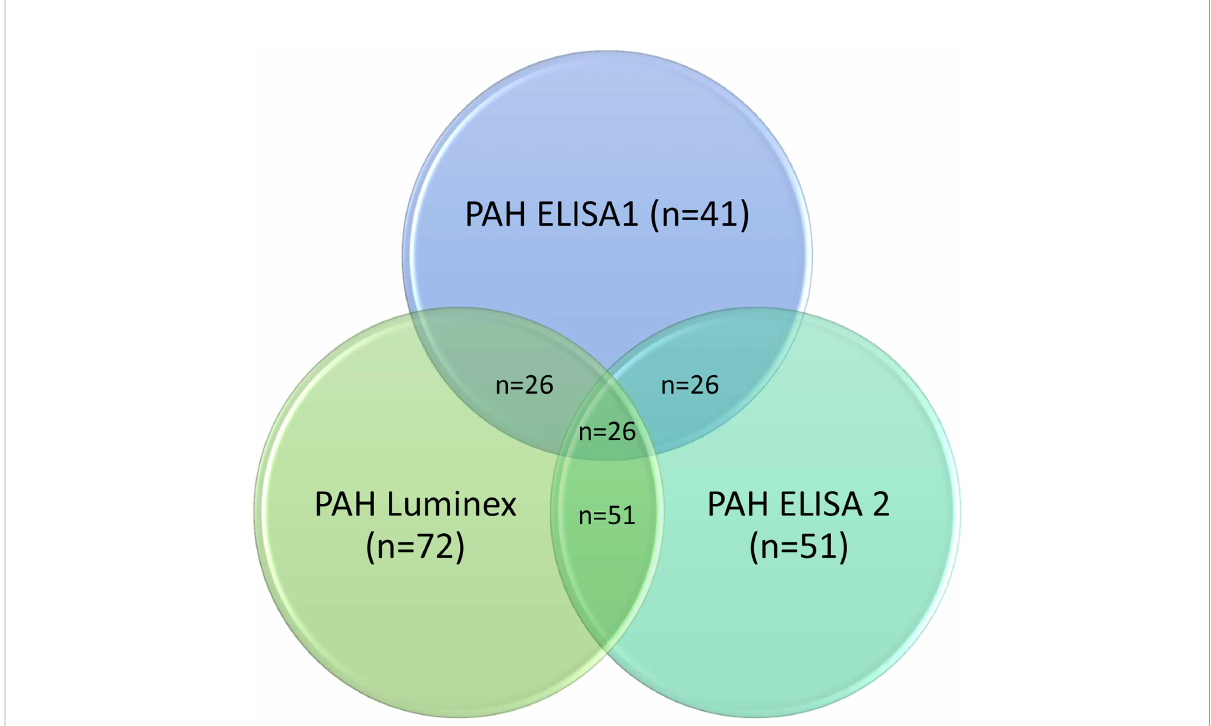
FIGURE 3 Overlapping PAH patients in ELISA1, Luminex and ELISA2. The number of PAH patients overlapping in ELISA1 and Luminex were 26 patients. Serum samples from these 26 patients were also included in ELISA. The number of patients overlapping in Luminex and ELISA2 were 51